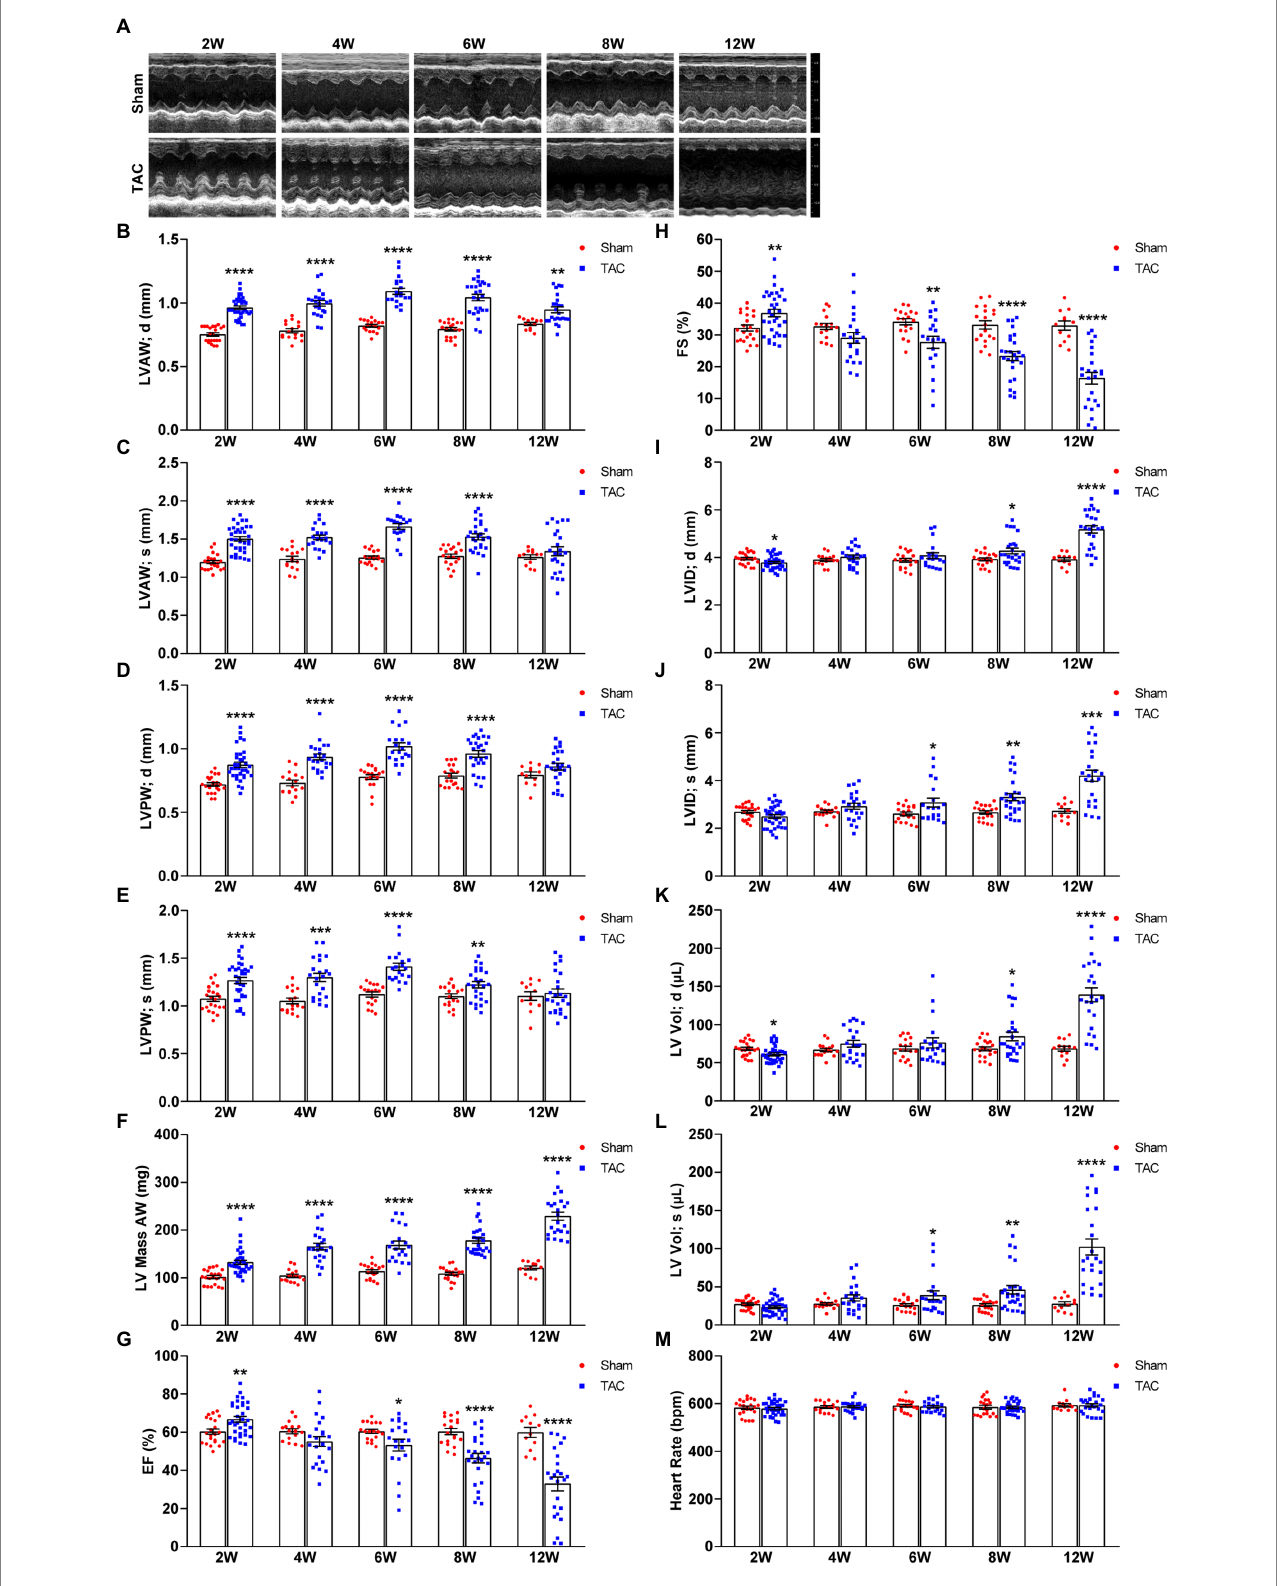
FIGURE 4 Echocardiography at various time points after surgery. (A) Representative two-dimensional guided M-mode echocardiogram of the various groups. (B) The thickness of the diastolic left ventricular anterior wall. (C) Systolic left ventricular anterior wall. (D) Diastolic left ventricular posterior wall. (E) Systolic left ventricular posterior wall. (F) Left ventricular mass AW. (G) Quantification of ejection fraction (EF). (H) Quantification of fractional shortening (FS). (I) Diastolic left ventricular internal dimensions. (J) Systolic left ventricular internal dimensions. (K) Diastolic left ventricular volume. (L) Systolic left ventricular volume. (M) Heart rate. n = 12~34. Unpaired t -test for two-group comparisons, * p < 0.05, ** p < 0.01, *** p < 0.001, **** p < 0.0001 vs. corresponding